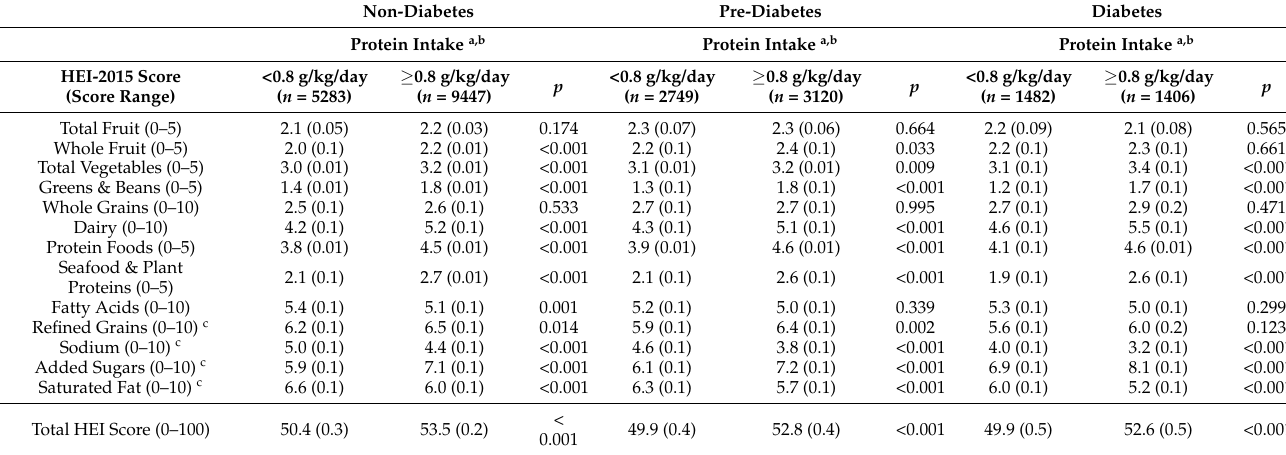
Table 4. Differences in Healthy Eating Index 2015 scores across diabetes status and in those below or meeting the protein intake recommendation. Non-Diabetes Pre-Diabetes Diabetes Protein Intake a,b Protein Intake a,b Protein Intake